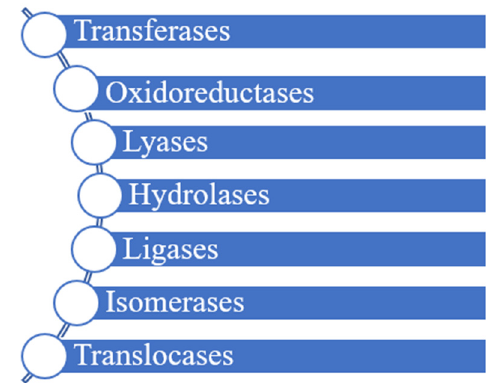
Figure 11. Classes of